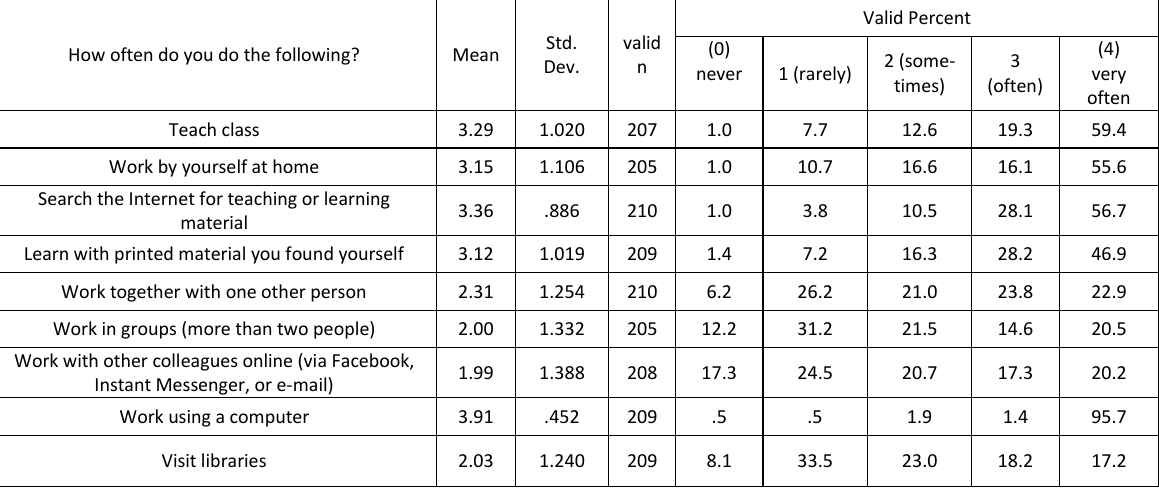
Table 3. Instructors’ responses to the question: How often do you do the following?